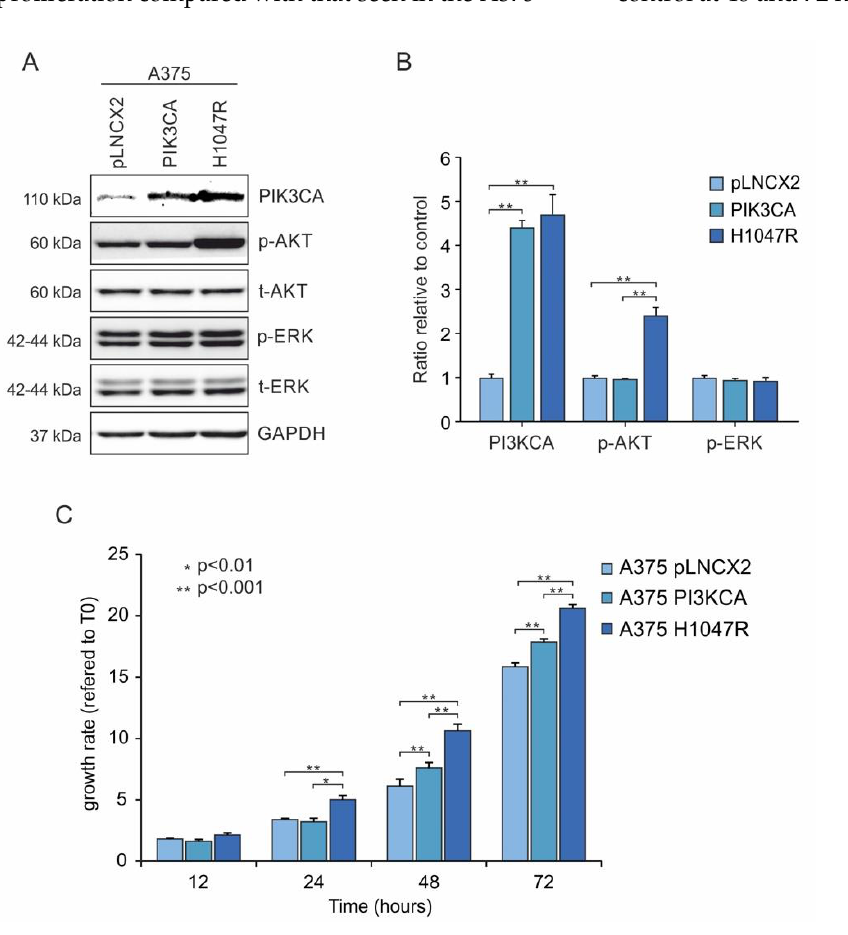
Figure 2. Transduction efficiency of retroviral infection and cell growth analysis. ( A ) Western blot analysis of A375 H1047R compared with that of A375 PIK3CA and A375 pLNCX2 . ( B ) Protein levels of p-ERK, p-Akt, and total ERK; Akt was evaluated to verify the transduction efficiency. ( C ) Cell growth was evaluated by MTT assay at 12, 24, 48, and 72 h. All experiments were performed in triplicate. * p ≤ 0.05; ** p ≤ 0.01.